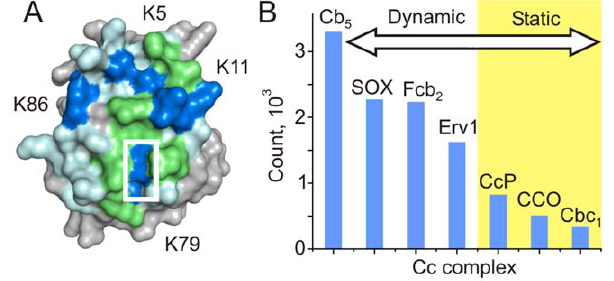
Figure 7. Cc binding interface and ET properties in redox complexes. (A) Combined binding interface of ferric yeast Cc (PDB entry 2YCC) [73] in complexes with CcP [74], Cb 5 [56] and CCO [67] as determined by solution NMR spectroscopy. Residues